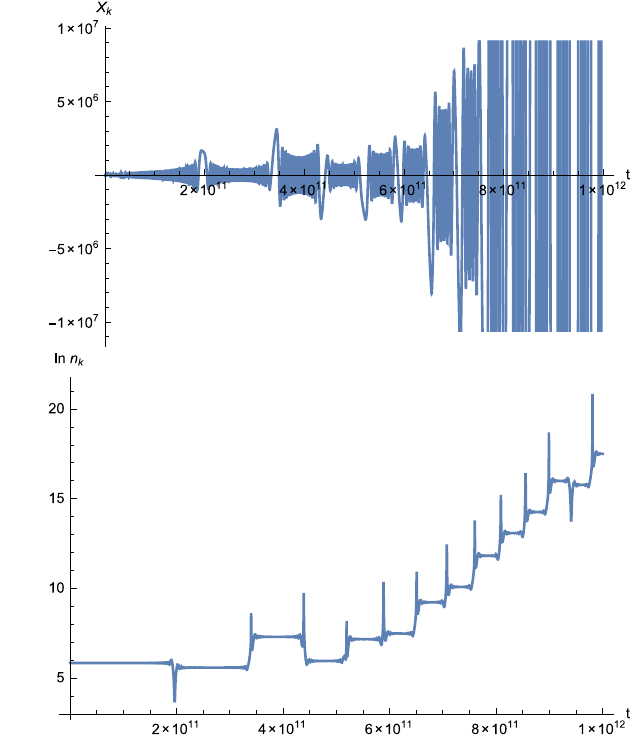
Fig. 3 The numerical plot of X k and ln n k in terms of cosmic time t before curvaton domination. We choose the parameters as ξ = 1, M = 10 − 4 M p , m = 10 − 6 M p , g = 4 . 8 × 10 − 3